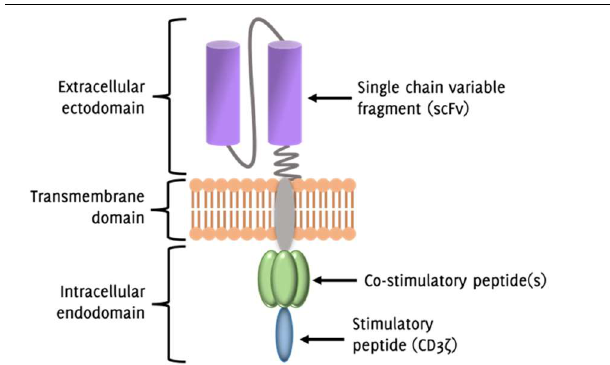
Figure 2. Structure of the Chimeric Antigen Receptor (CAR)-T cell